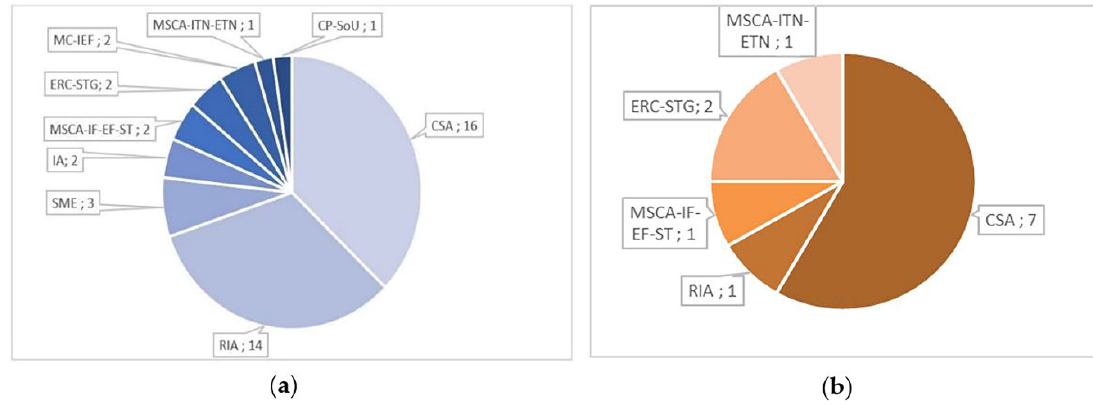
Figure 3. Number of projects per funding program. Image elaborated by the authors.